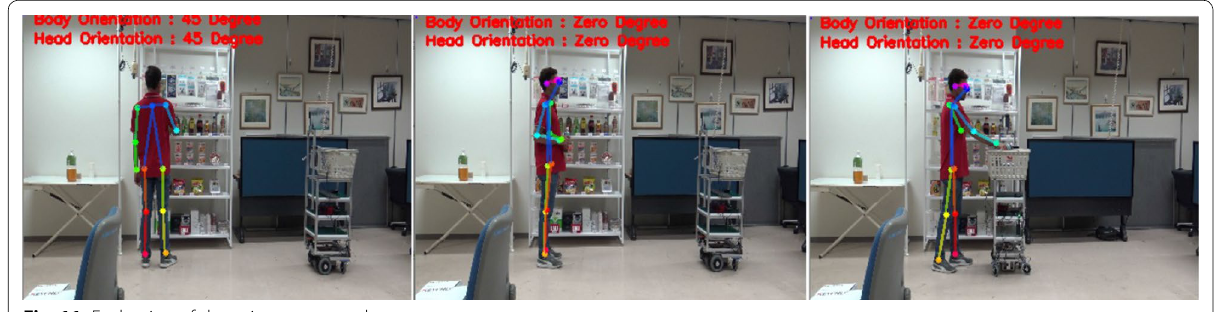
Fig. 11 Evaluation of shopping support robot